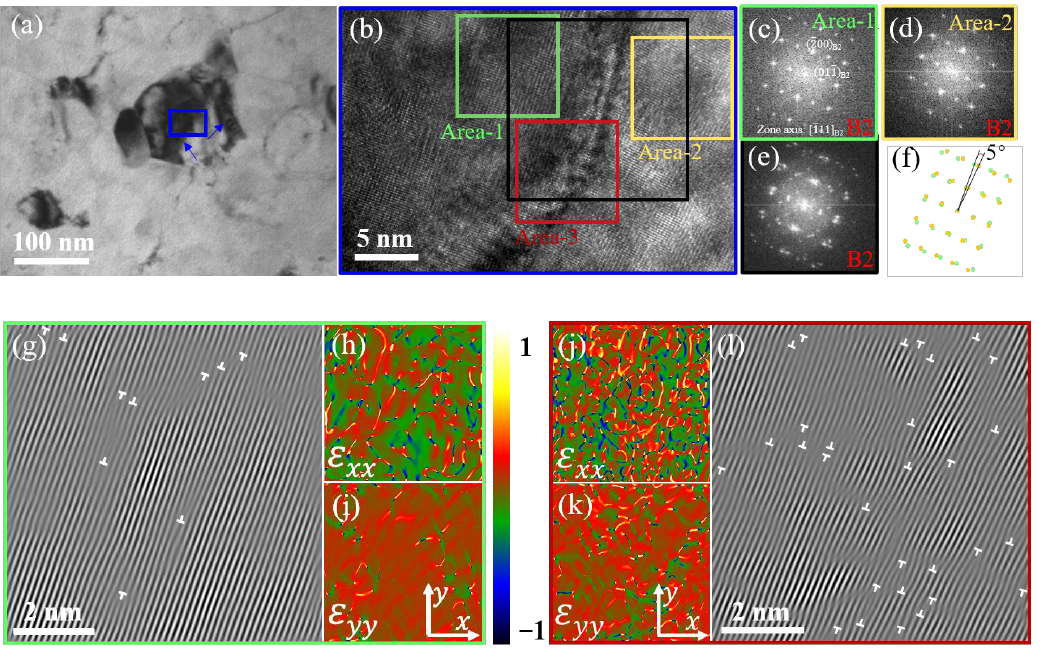
Figure 10. TEM observation of the trained sample: ( a ) bright-field image; ( b ) HRTEM image; ( c – e ) show the fast Fourier transformation (FFT) patterns; ( f ) is an indexed FFT pattern sketch of ( e ); ( g , l ) show the IFFT of ( c , e ); ( h , i ) and ( j , k ) are, respectively, the GPA results of area-1 and area-3 in ( b ).